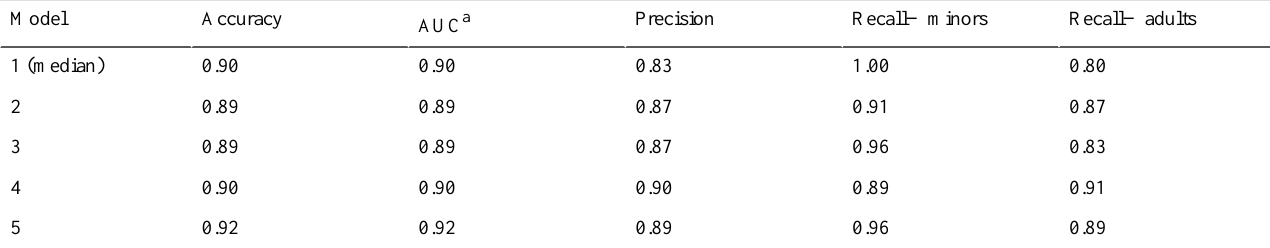
Table 7. Performance results for the Random Forest algorithm on each of the outer cross-validation test sets, for the male sample. Recall—adultsRecall—minorsPrecisionAUC a